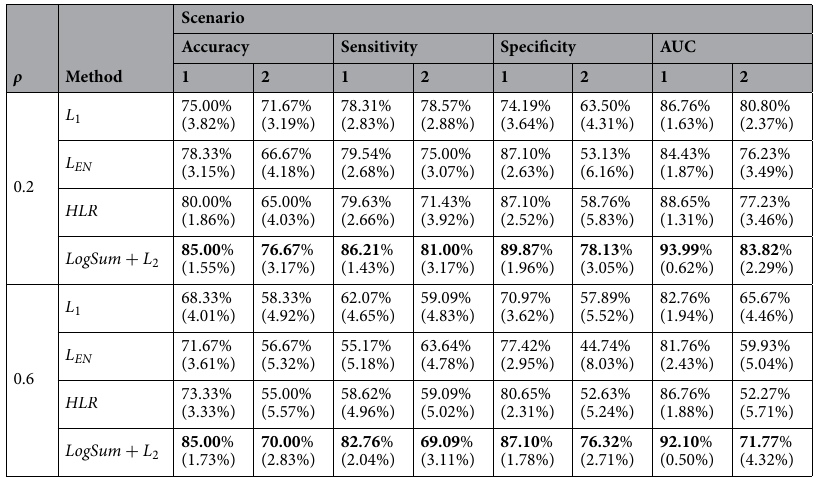
Table 2. Test results of different methods on the simulated datasets. Numbers in parentheses are the standard deviations and the best results are highlighted in bold.